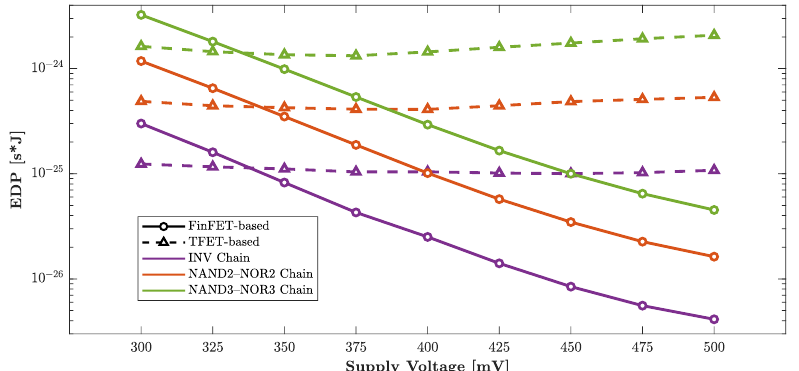
Figure 5. Energy–delay product over a supply voltage range from 300 mV to 500 mV for TFET and FinFET-based chains made out of inverters (INV), NAND2–NOR2, and NAND3–NOR3 gates.